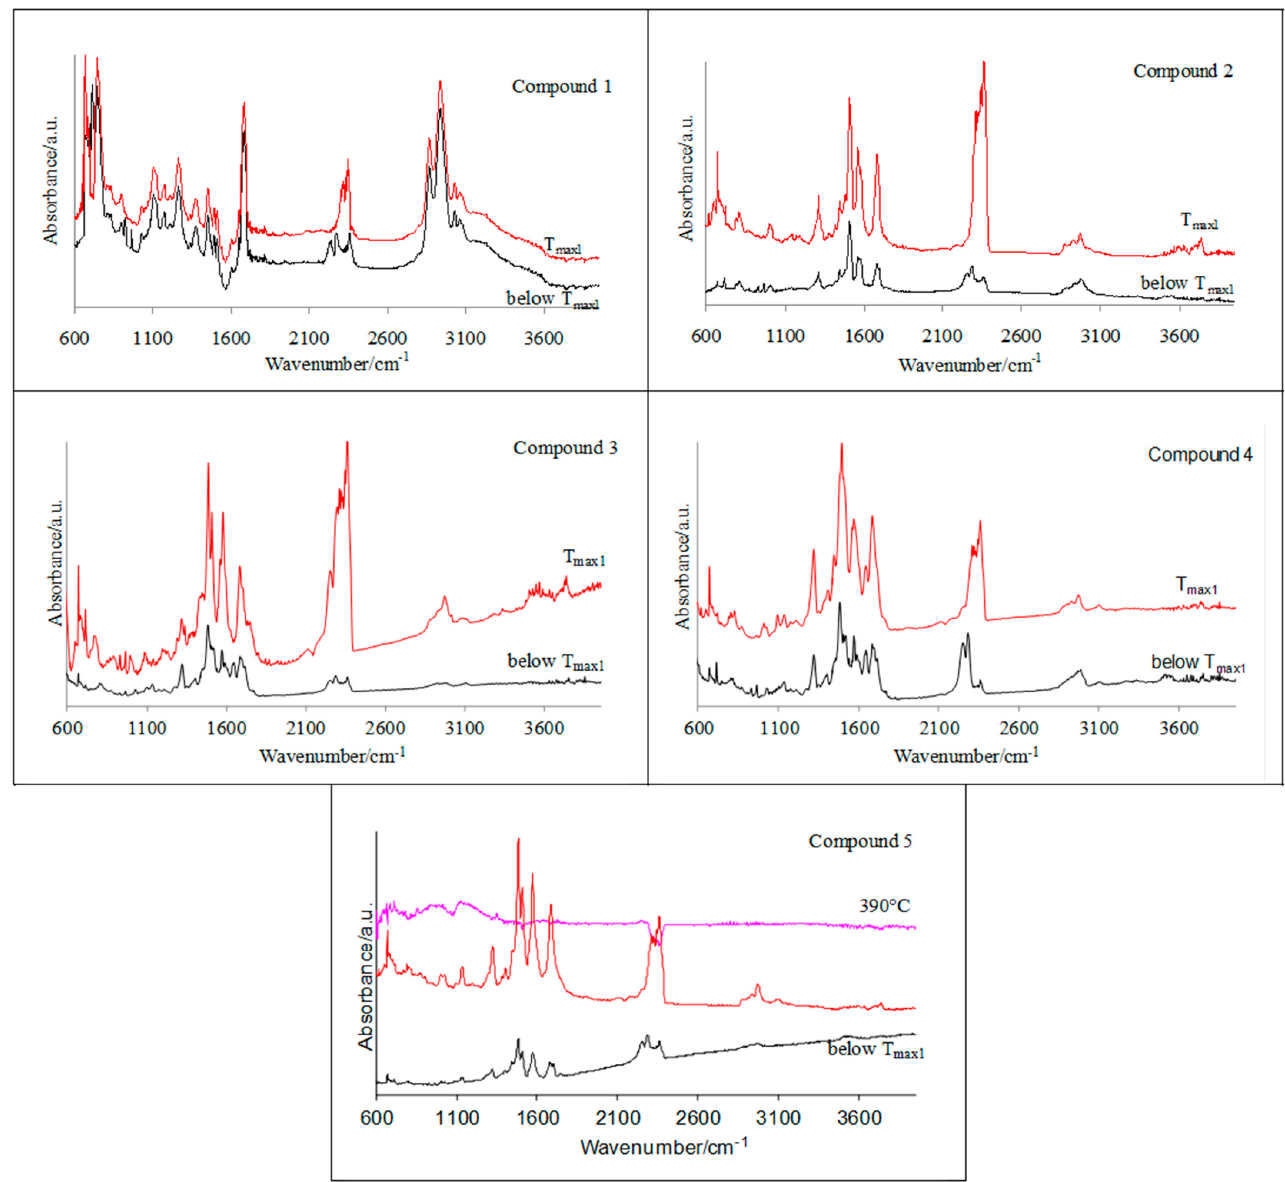
Figure 4. The FTIR spectra of volatiles emitted under the heating of the tested compounds 1 – 5 (a helium atmosphere).